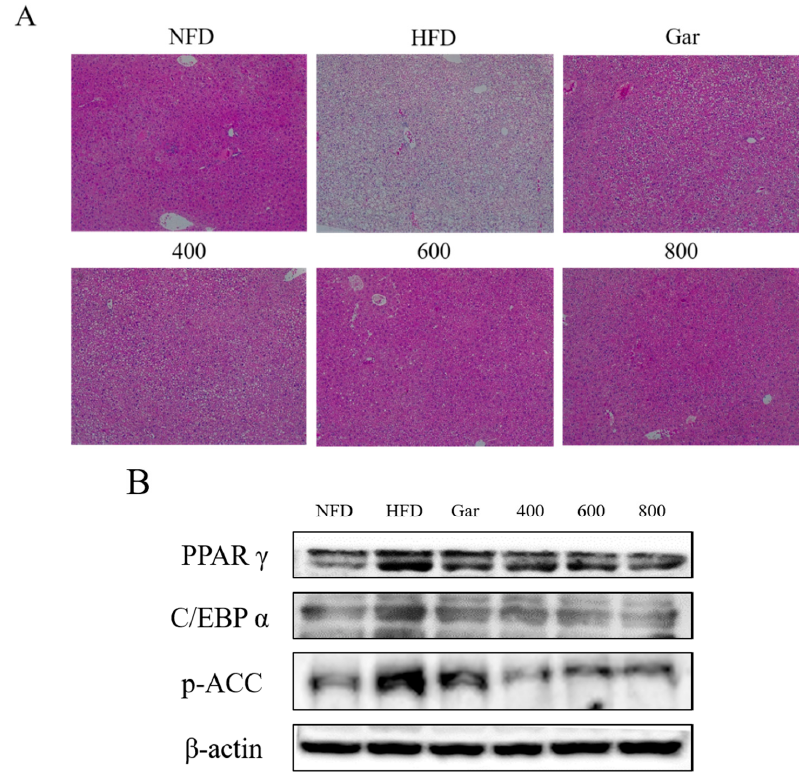
Figure 5. ( A ) Histological change of the liver. Hematoxylin and eosin (H&E) stained sections of liver tissues were observed with an optical microscope at × 100 (Axiovert 100, Germany). ( B ) The expression of PPAR γ , C/EBP α , p-ACC, and β -actin in the liver was analyzed by Western blot analysis. NFD; Normal-Fat Diet. HFD; High-Fat Diet. Gar; Garcinia 245 mg/kg/day. 400; The ethanol extract of Cheongchunchal (CE) 400 mg/kg/day. 600; CE 600 mg/kg/day. 800; CE 800 mg/kg/day.